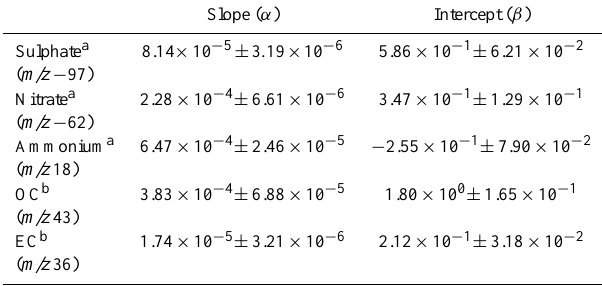
Table 3. Mass calibration factors derived from a correlation of the scaled ATOFMS volumetric intensity (Vs, µm 3 ) and GPIC/Sunset OCEC measurements (µgm − 3 ) for PM 2 . 5 chemical components during the SPORT campaign (parameter values ± standard